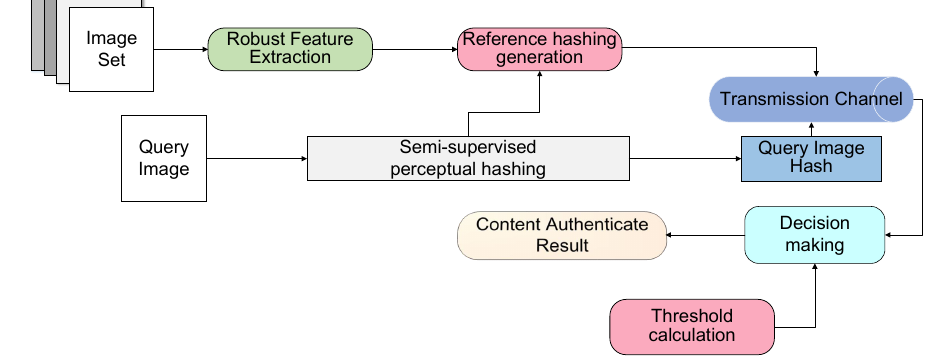
Figure 1. Block diagram of the proposed